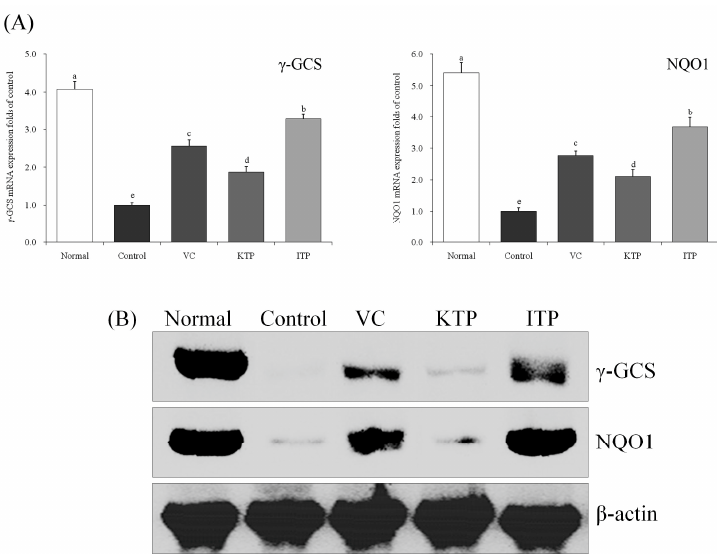
Figure 11. Expression of mRNA ( A ) and protein ( B ) for γ -GCS and NQO1 in spleen of mice. a–e Mean values with different letters in the same bar represent significant differences ( p < 0.05) according to Duncan’s multiple-range test. VC: vitamin C (200 mg/kg body weight); KTP: Kuding tea polyphenols (200 mg/kg body weight); ITP: insect tea polyphenols (200 mg/kg body weight).